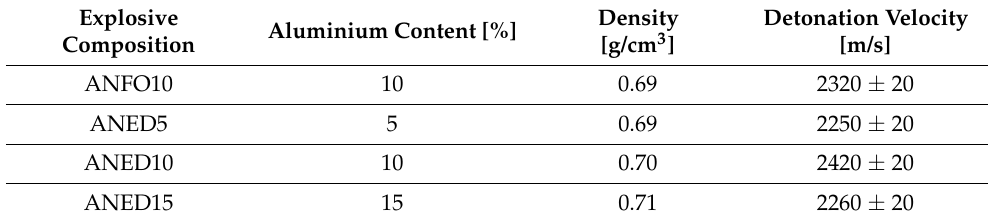
Table 7. Detonation velocity of AN/fuel compositions with the addition of flaked aluminium